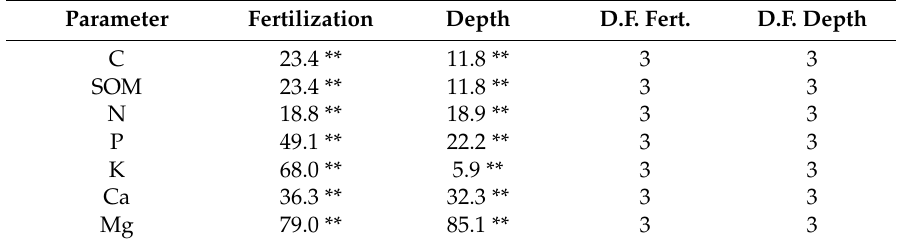
** Significant effect at the p < 0.01 level; D.F. degrees of freedom.